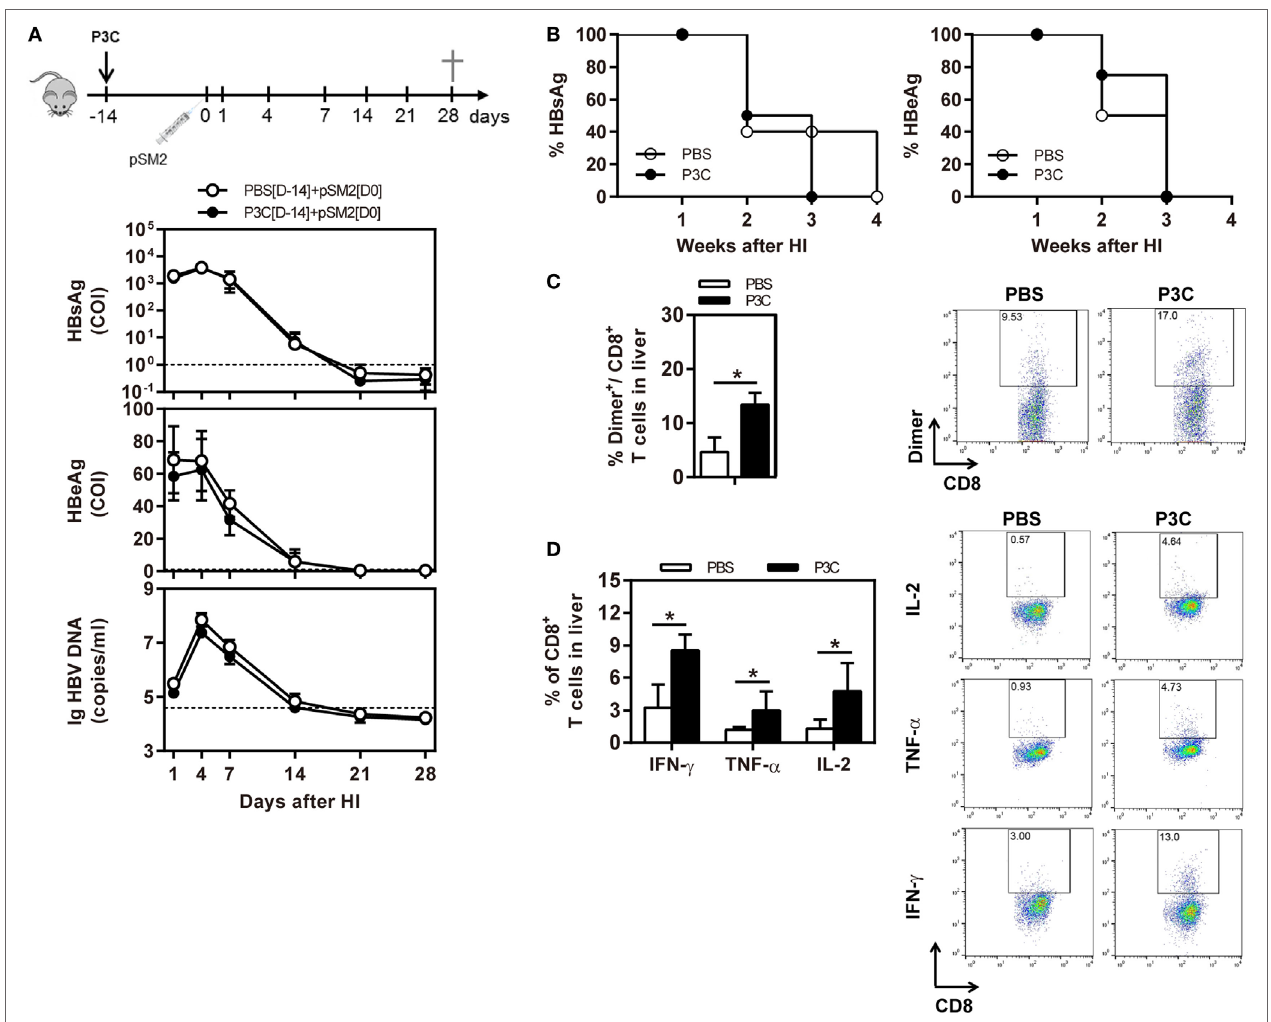
FigUre 6 | Pretreatment with P3C does not accelerate hepatitis B virus (HBV) clearance in the mouse model for acute HBV infection but promotes the HBV- specific T-cell response. C57BL/6 mice were pre-treated once with 20 µg of P3C or phosphate-buffered saline administered by intravenous (IV) injection at day 14 (D-14) before hydrodynamic injection (HI) with HBV plasmid pSM2. (a) Serological markers of HBV infection HBsAg, Hepatitis B e antigen (HBeAg), and HBV DNA were assayed at the indicated time points. (B) Positivity for HBsAg or HBeAg was defined as ≥ 1. (c,D) Lymphocytes were isolated from the mouse liver at day 28 after HI. (c) The specific CD8 + T cells against HBcAg Cor 93–100 epitope were detected by Cor 93–100 peptide-loaded dimer staining. (D) The functionality of intrahepatic HBV-specific CD8 + T cells was determined by intracellular cytokine staining after ex vivo stimulation with peptide Cor 93–100 for 5 h. The HBV-specific IFN- γ + , TNF- α + , and IL-2 + CD8 + T cells was detected by flow cytometry. Four mice were analyzed per group, and the experiments were repeated at least once. Statistically significant differences between the groups are indicated as * P < 0.05 and ** P <